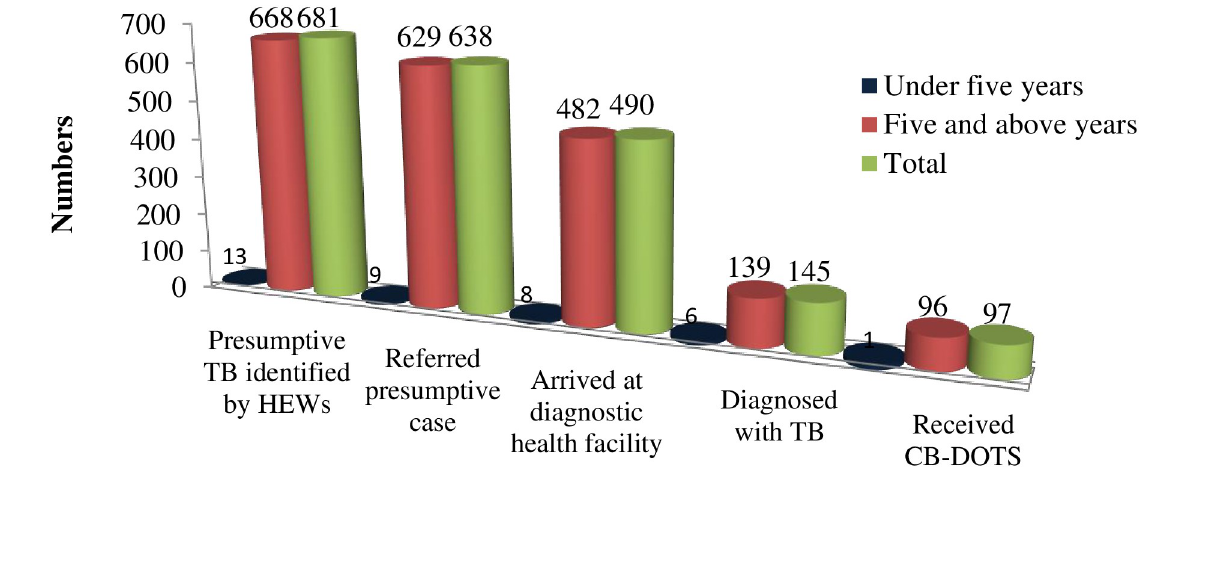
PLOS ONE | https://doi.org/10.1371/journal.pone.0271968 August 16,